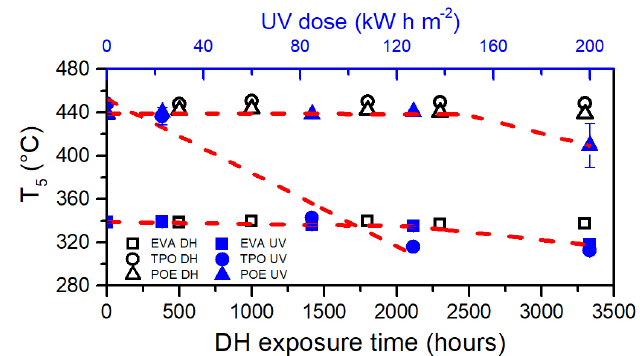
Figure 15. Temperature corresponding at 95% residual weight (T 5 ) versus exposure time (DH test, open symbols in black color) and dose (UV test, full symbols in blue color). Red dashed lines are linear fittings applied to the data to extrapolate the oxidation induction time/dose.